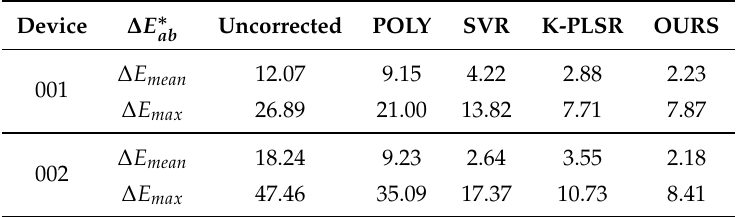
Table 7. Comparison results of the color differences using four methods for two